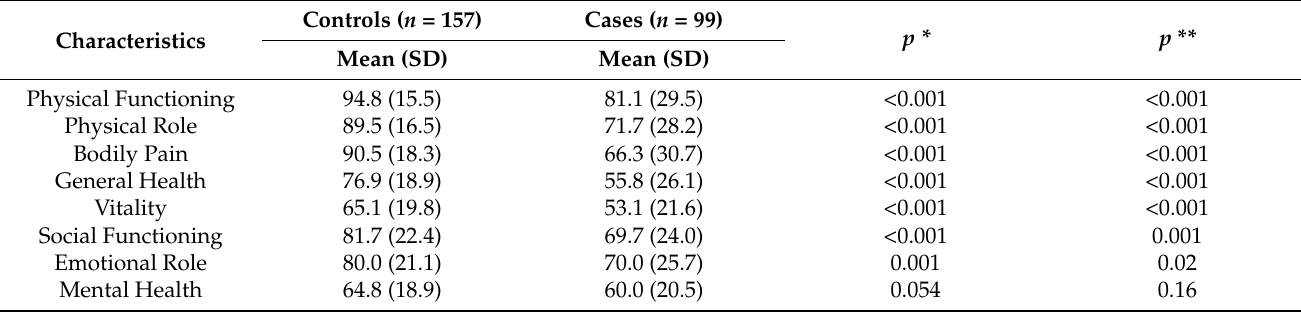
Table 2. Comparison of the health concept scales (0–100) of the SF-12v2 questionnaire between cases and